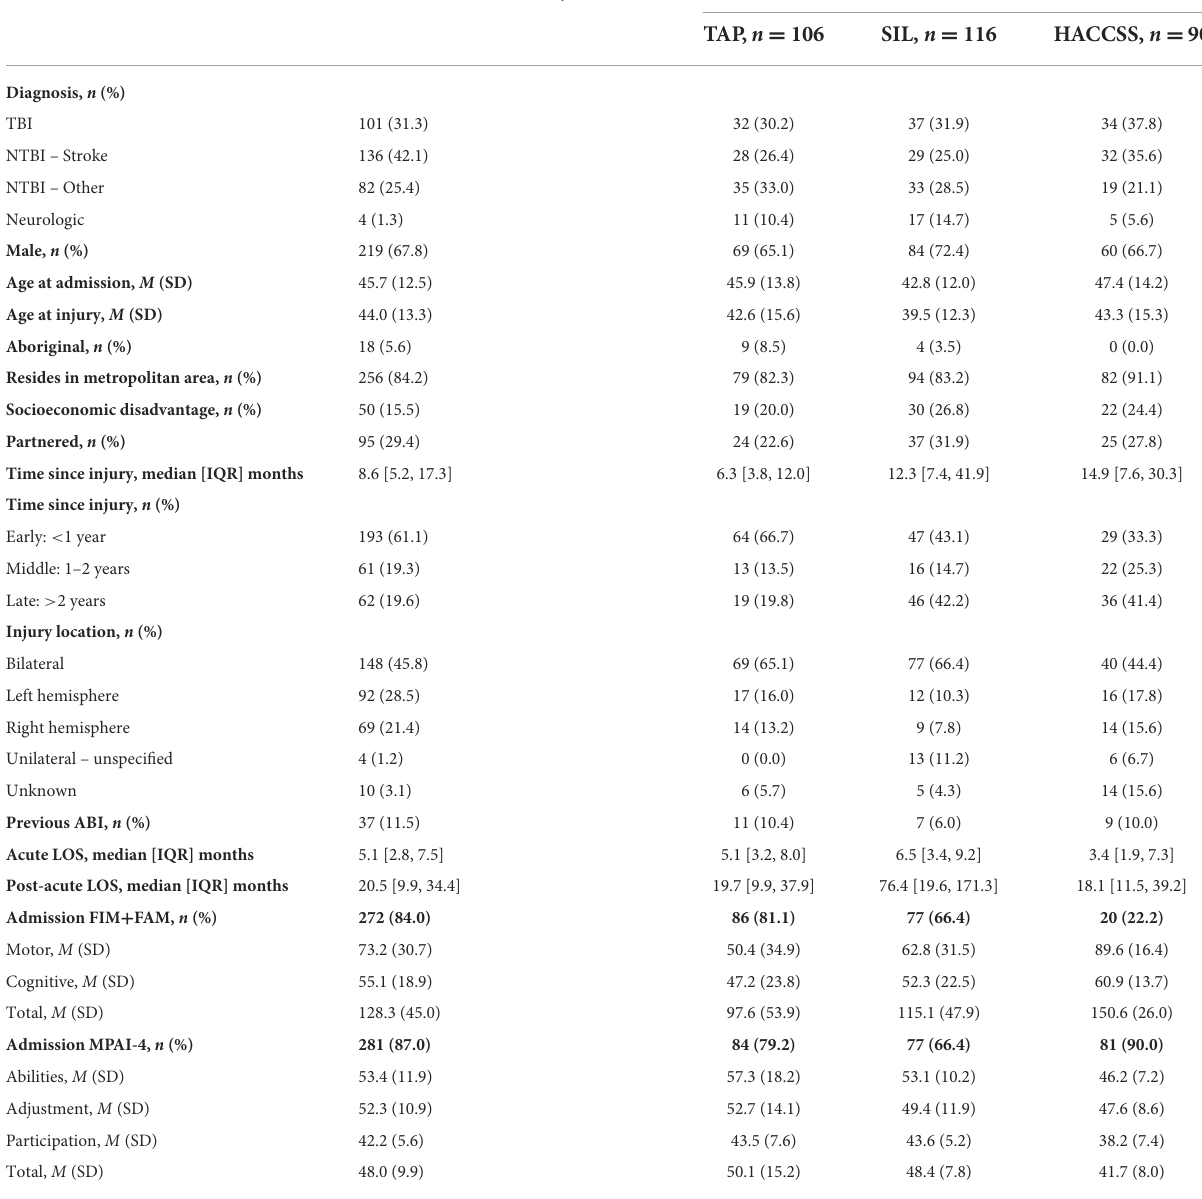
TABLE 1 Clinical and sociodemographic characteristics for the ABI-RESTaRT subcohort active between 2011–2020 ( n = 635).